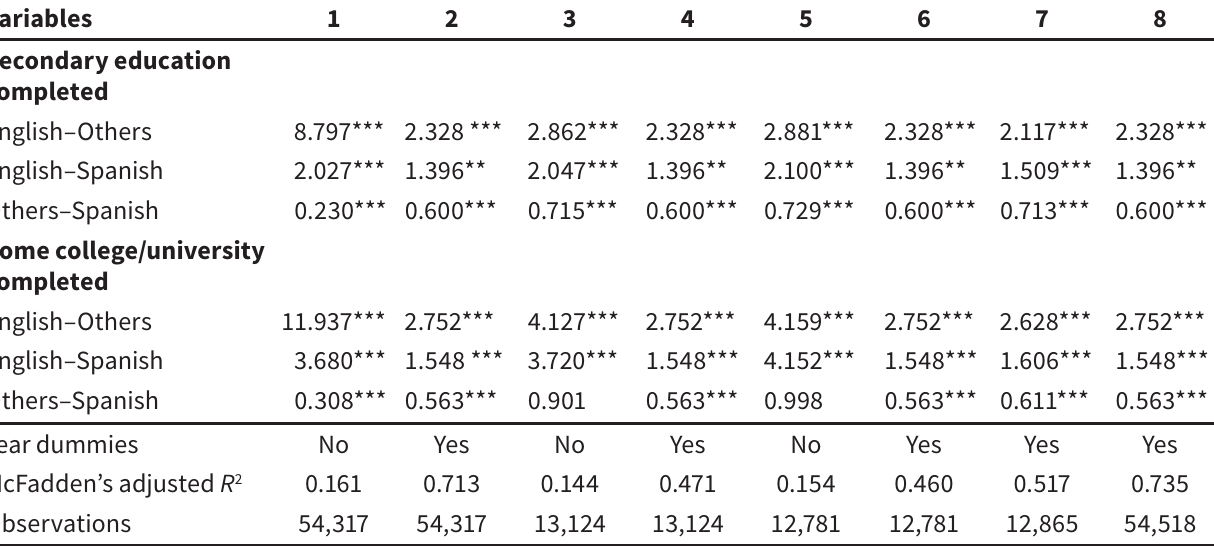
Location choice: destination countries classified by language (dependent variable: English, Spanish, and